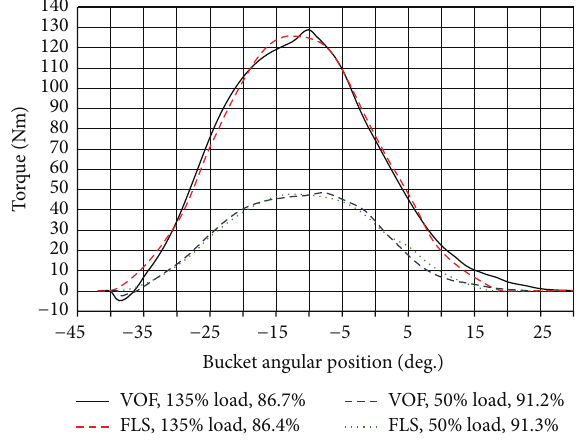
Figure 15: Comparison of VOF and FLS method for off design turbine operation